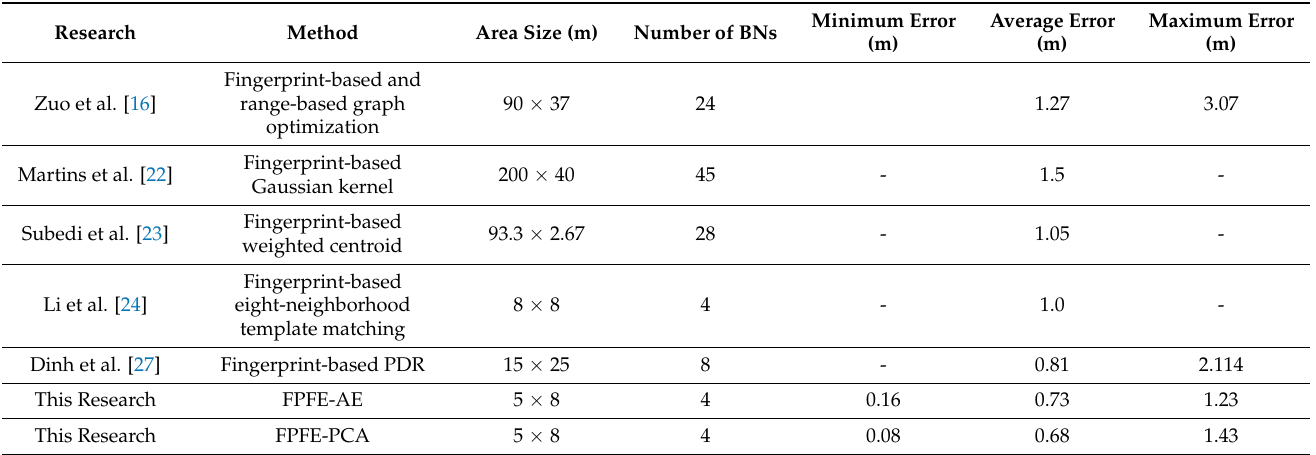
Table 3. Comparisons of FPFE-AE and FPFE-PCA with other fingerprint-based